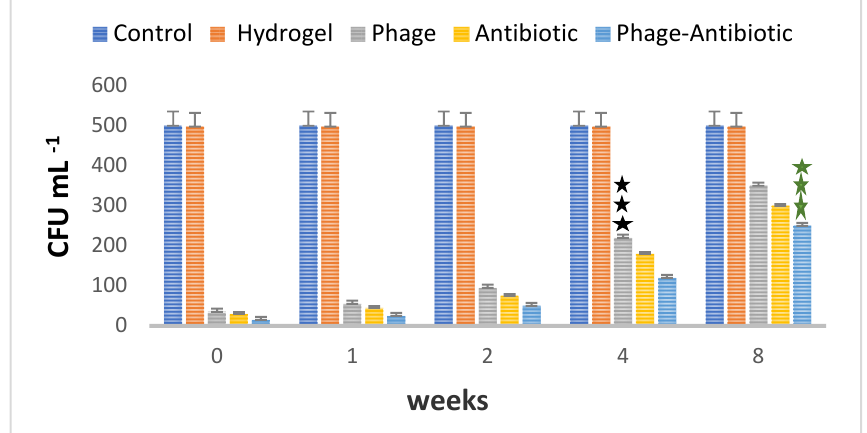
Figure 11. Evaluation of the stability of the phages in the hydrogels over 8 weeks, as estimated by the reduced killing efficiency over time. The results are based on three repeats, showing the average with standard deviations. all other weeks of the phage group ( p < 0.001). indicates that the phage–antibiotic 8 is signif-